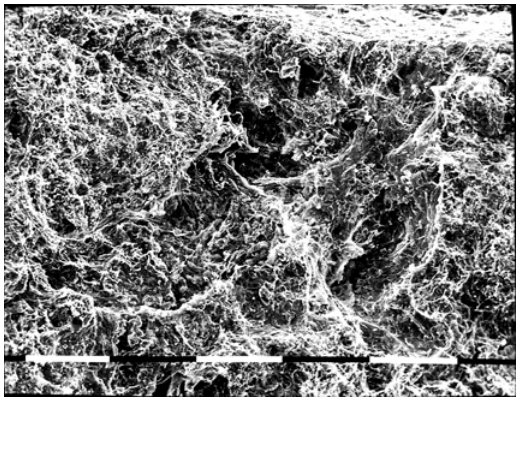
FIGURE 11 . SEM micrograph of peri-implant tissue in direct contact with the removed TPS screw 3 months after surgery. A rough surface of mineralized mature bone with a small bone concavity complementary to the irregular TPS surface can be seen in the areas between 2 threads. Bar = 10